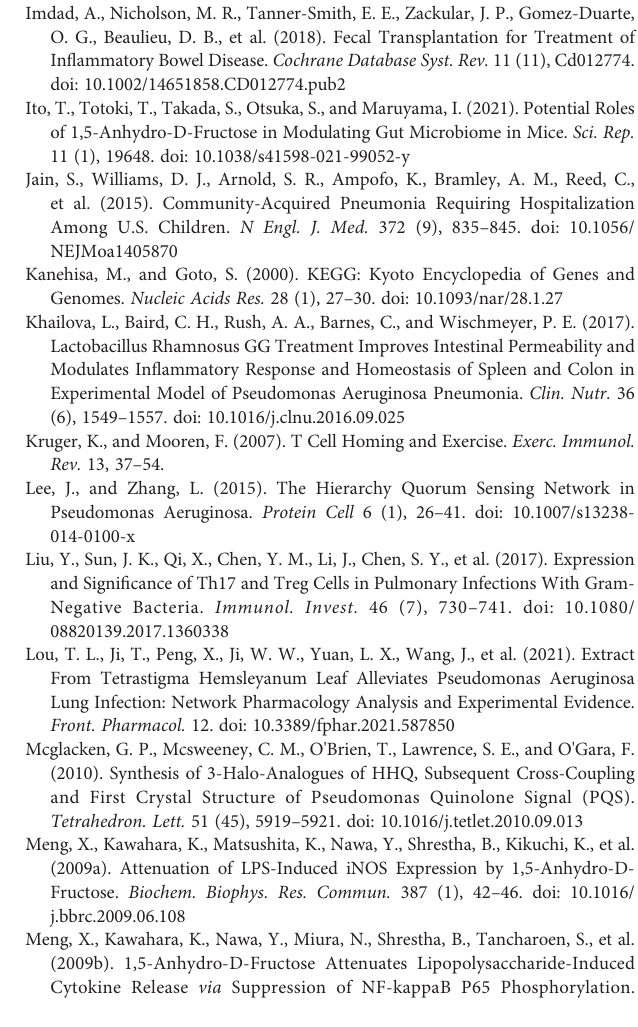
Supplementary Figure 1 | The methodology of the